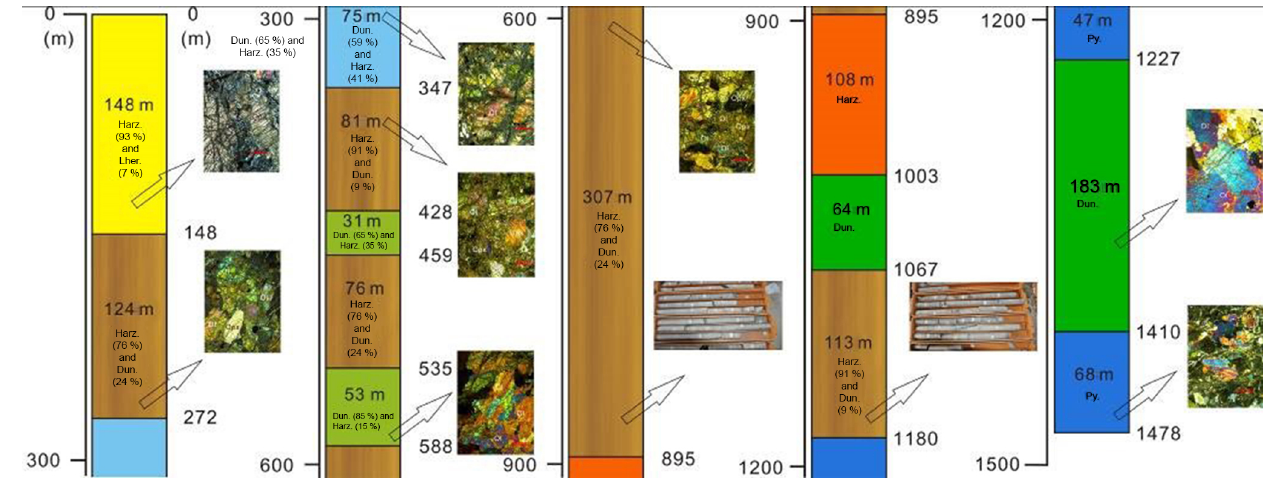
Figure 16. Lithological profiles of the LBSD-ZK1 at the Luobusha ophiolite massif in Tibet.